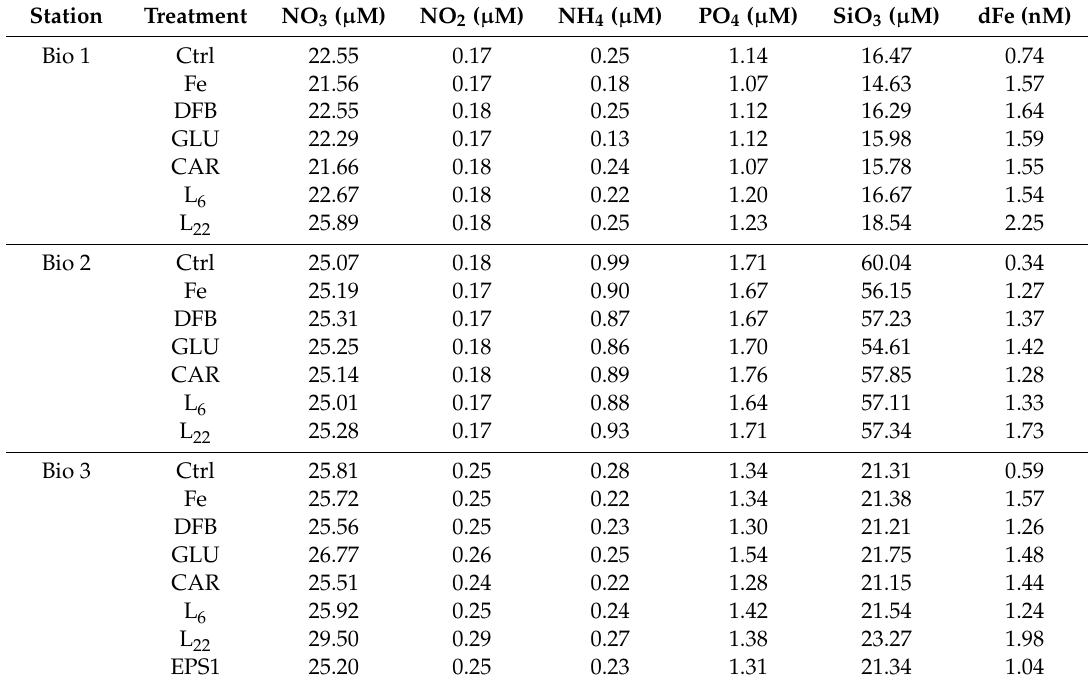
Table 2. Concentrations of macronutrients and Fe determined at the beginning of the incubation of each treatment: Ctrl (control), Fe (inorganic Fe addition, FeCl 3 ), DFB (Fe complexed to desferrioxamine B), GLU (Fe complexed to glucuronic acid), CAR (Fe complexed to carrageenan), L 6 (Fe complexed